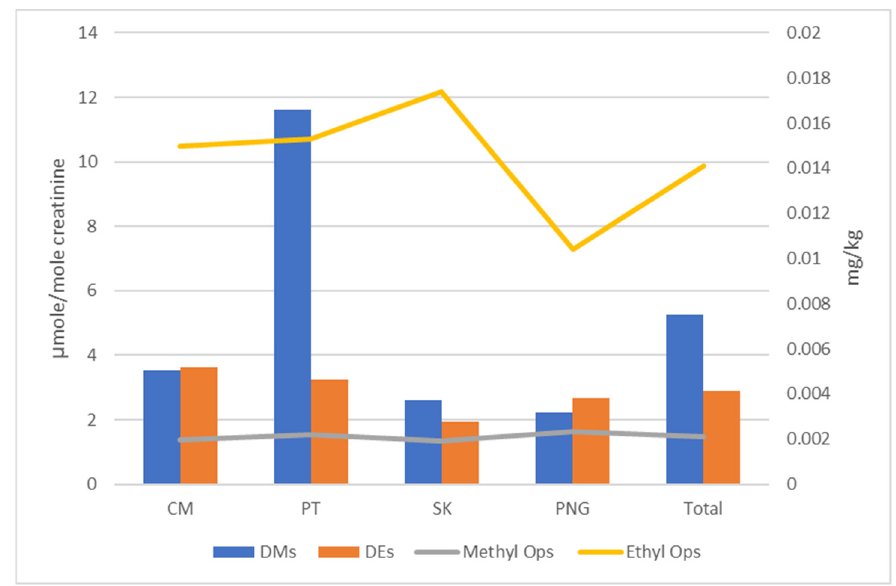
Figure 3. Comparison of DAPs levels in urine samples (bar chart) and OPs residues levels in vegetable samples (line chart) by province.